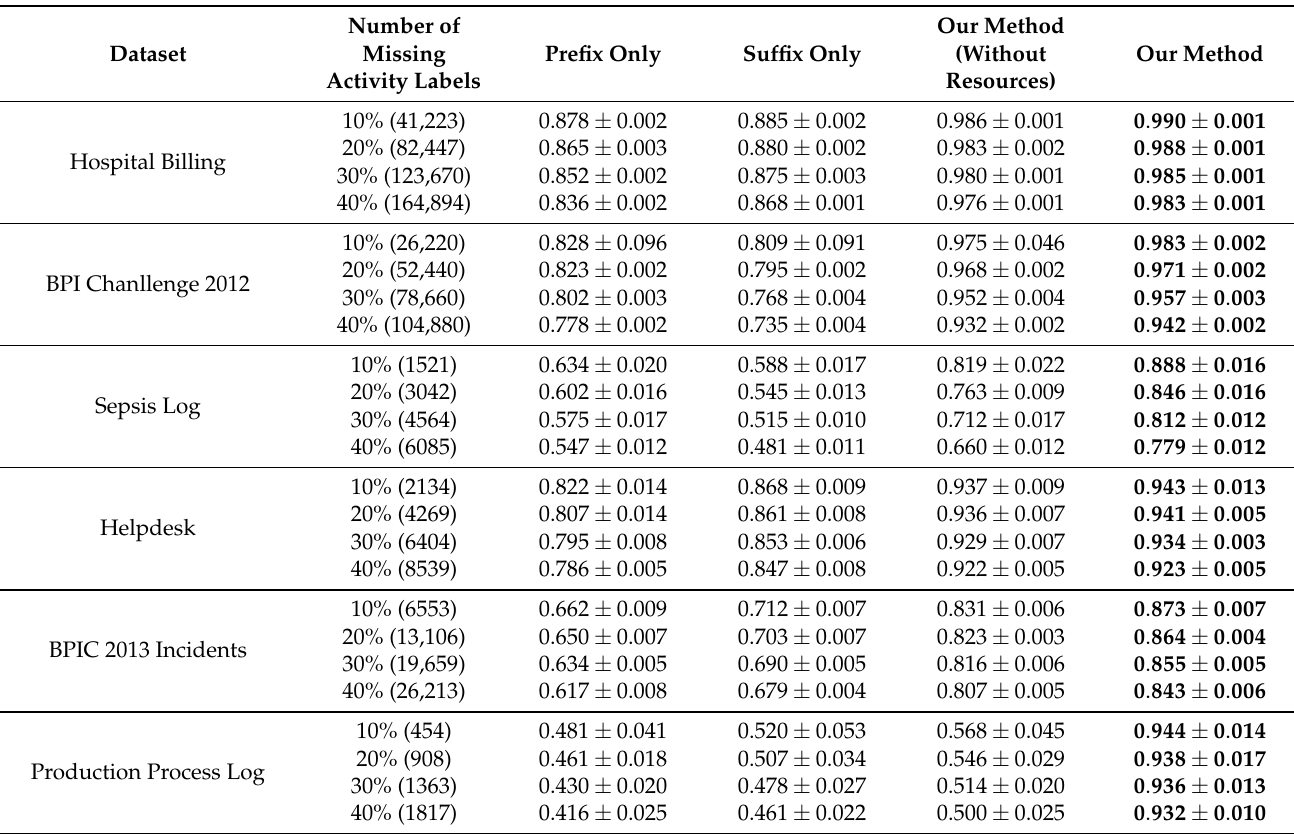
Table 8. Further analysis of our